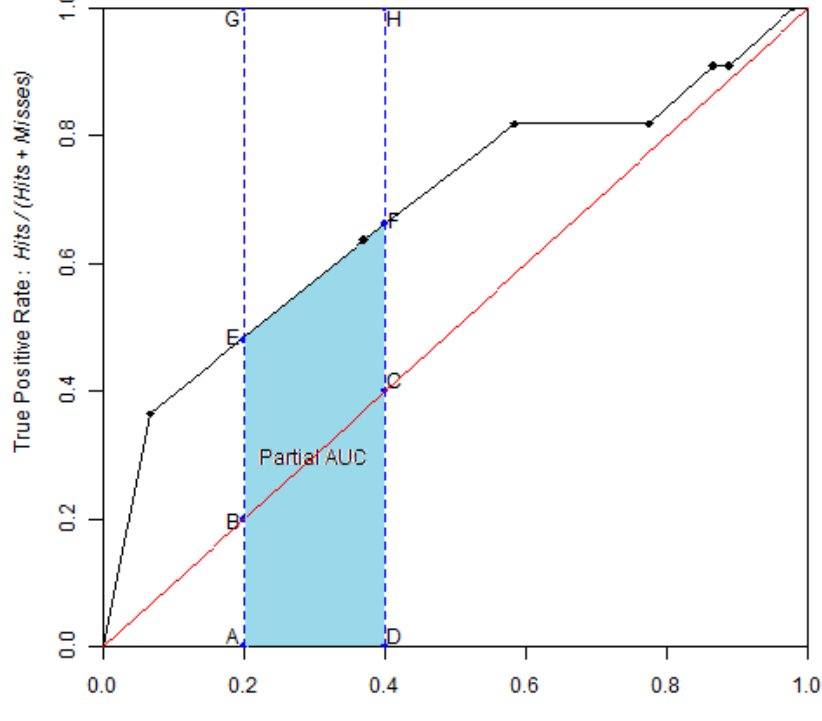
Figure 3. Partial area under the curve (AUC) for a range on the horizontal axis. pAUC corresponds to the area AEFD. Its value is standardized using the pAUC of a random model (area ABCD) and a perfect model (area